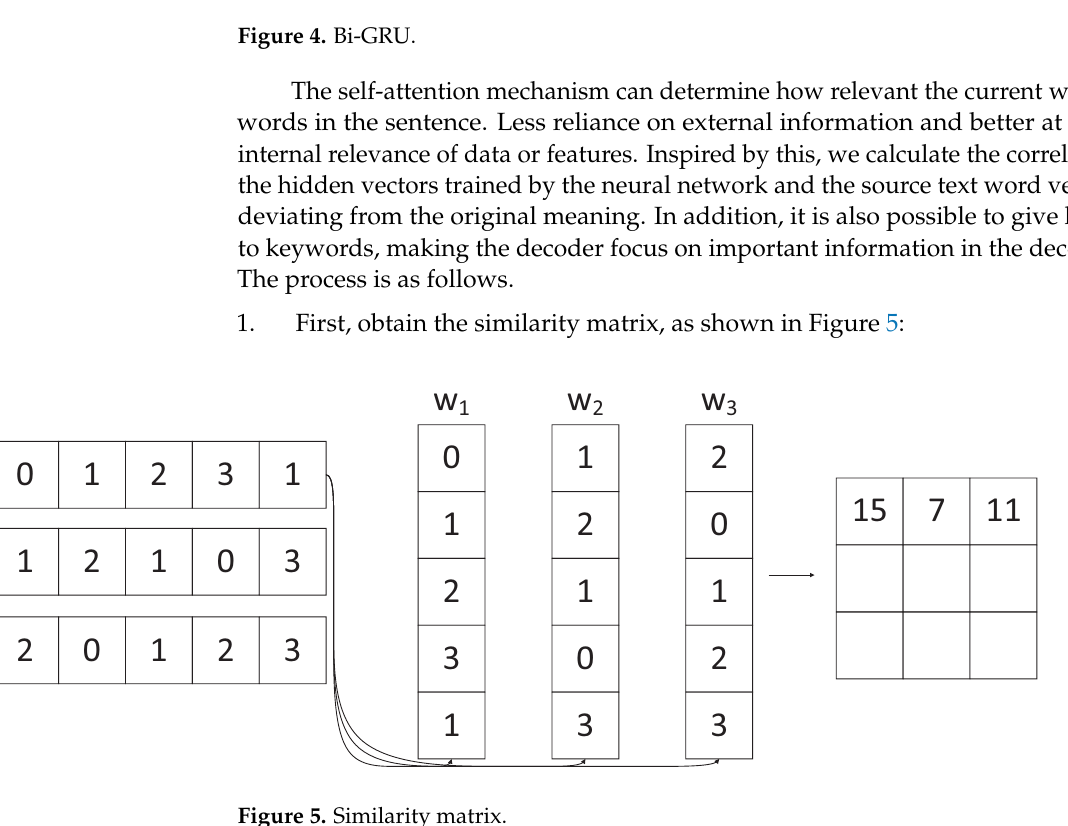
Figure 5. Similarity matrix. 2. Normalization, as shown in Figure